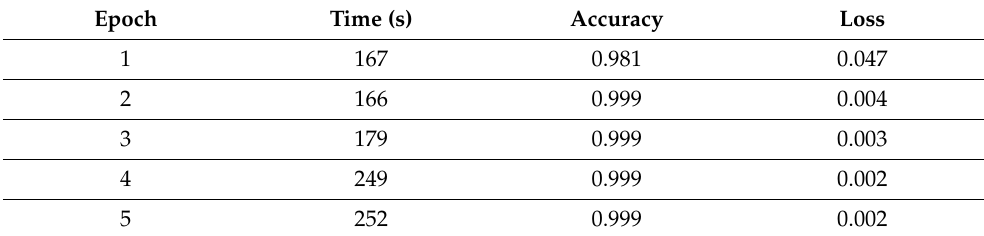
Table 5. Training dataset of 2 March 2018 with the initial features